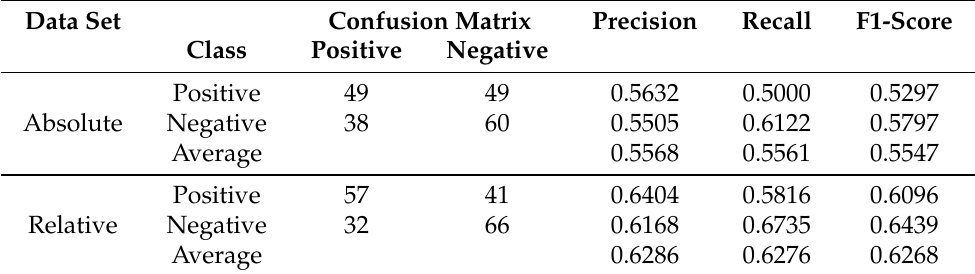
Table 7. Summary of classification accuracy for positive and negative